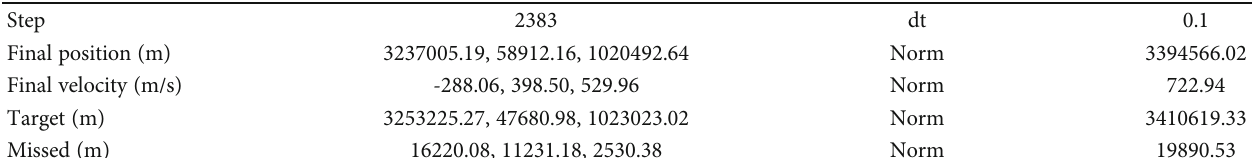
Table 9: Linear integration using 10-layer NN in the Mars model.